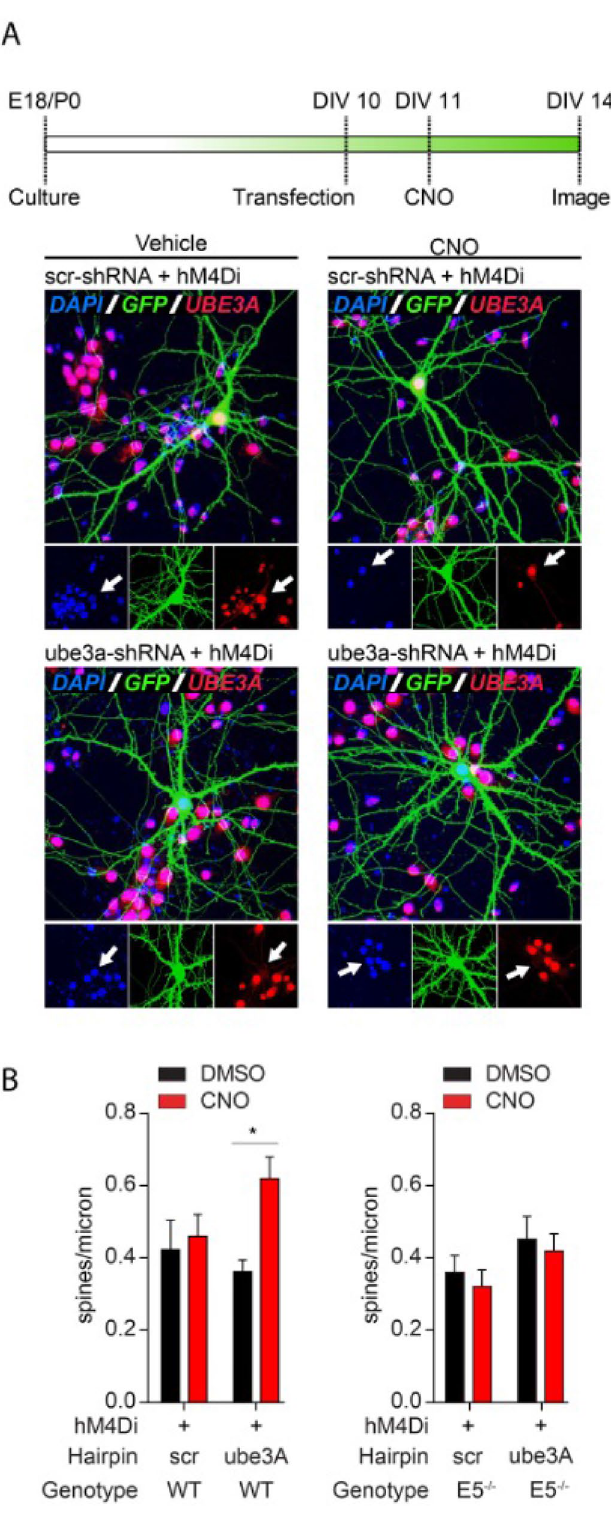
Figure 5. Knockdown of UBE3A leads to an activity dependent increase in dendritic spine formation that requires Ephexin5. ( A ) Hippocampal neuronal cultures were transfected at DIV 10 with plasmids containing GFP, an shRNA hairpin, and hM4Di, and treated with CNO or vehicle from DIV 11–14. Representative neurons at DIV 14 are shown, with white arrows indicating the soma of the transfected cells. Cells were stained for UBE3A (red) and GFP (green). Nuclei were labeled with Hoescht. ( B ) For each treatment group, spine density is shown as spines per micron across the entire transfected neuron. Data are presented as mean ± SEM (n = 3 for all genotypes). * p < 0.05 (two-way ANOVA) within genotype with post-hoc Sidak’s multiple comparisons test. Exact p values are reported Supplementary Table 2 and Supplementary Table